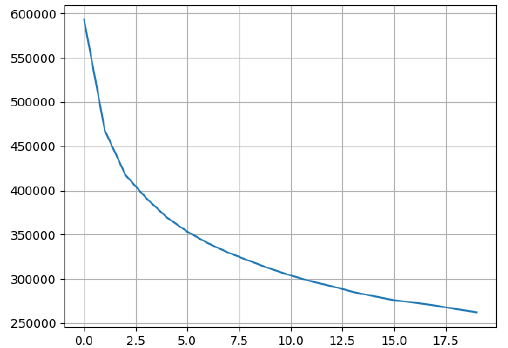
Figure 6. Elbow inertial